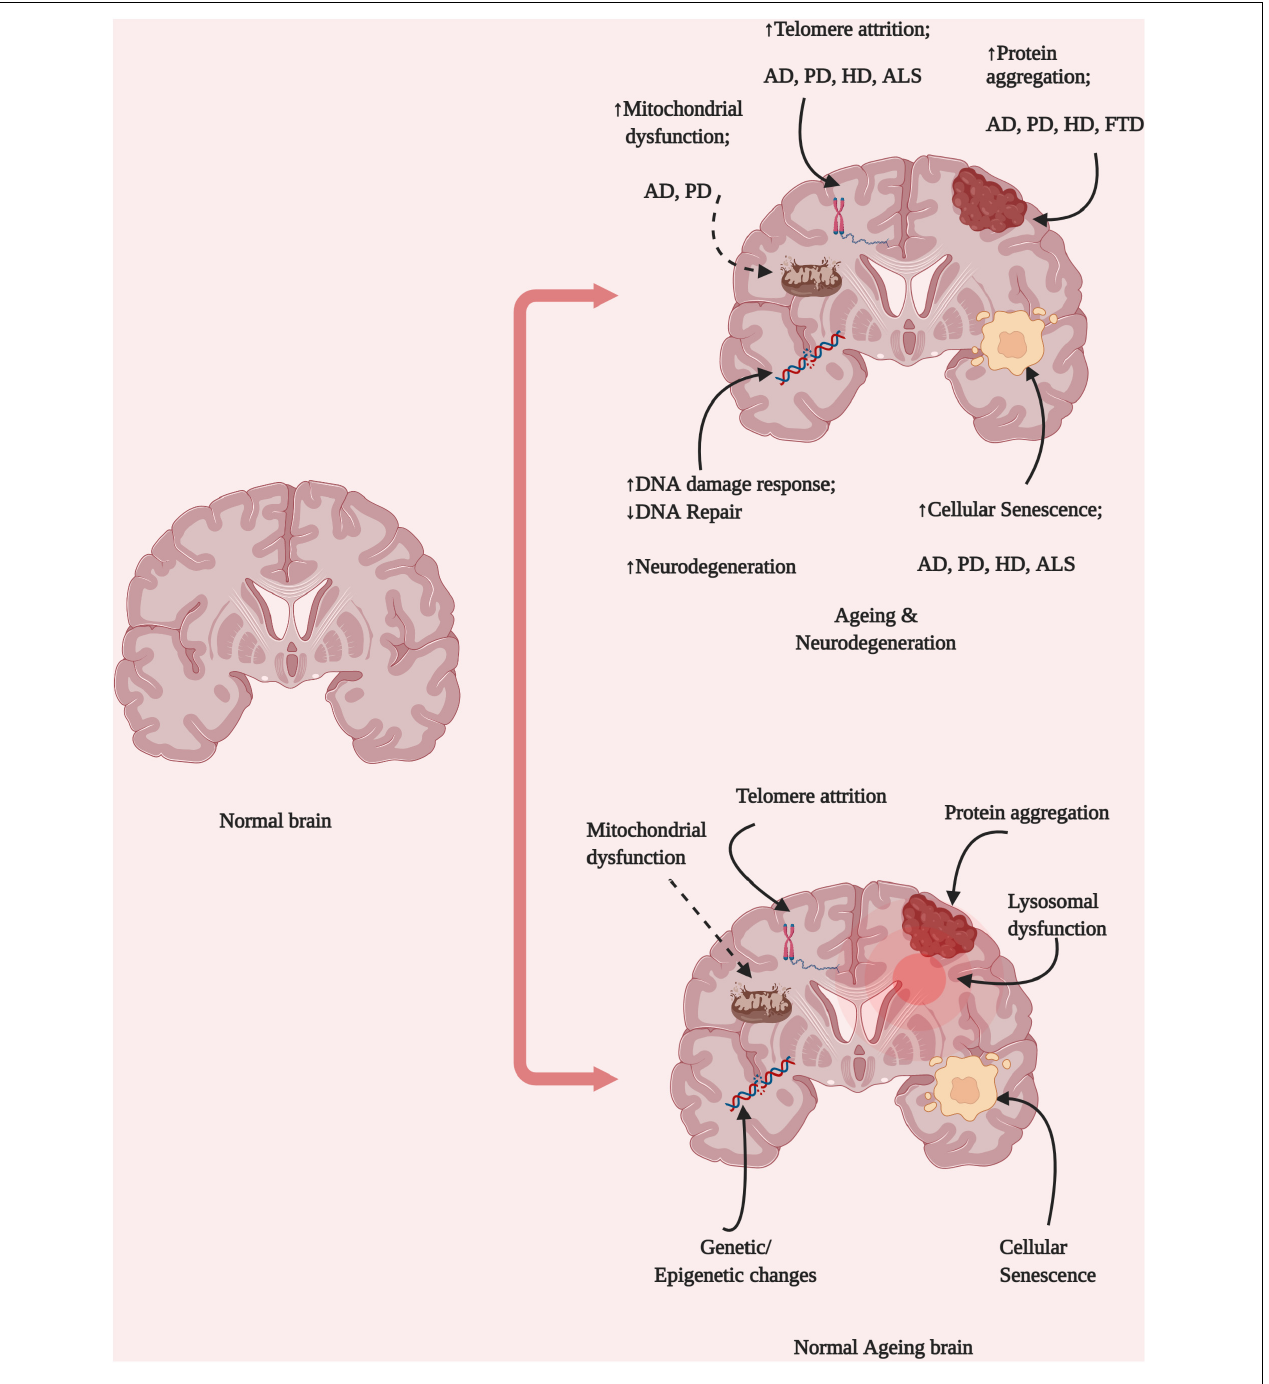
FIGURE 1 | Brain ageing hallmarks and neurological diseases. Ageing represents the combined disruption of several homeostatic processes, including protein aggregation, DNA damage, mitochondrial dysfunction, lysosomal dysfunction, and changes in epigenetic regulation. These changes might be dependent on different cell types and result in the development of various diseases depending on their origins in different brain locations and the pattern of propagation (Created with BioRender.com).